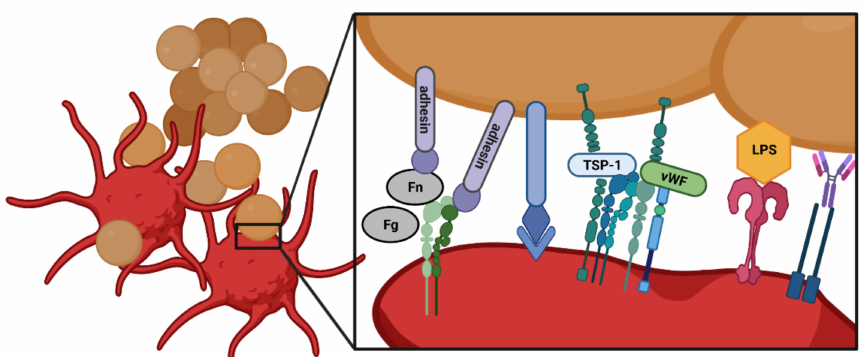
Figure 3. Binding of bacteria to platelets occurs either directly or indirectly. Bacterial adhesins with specific repeating units can utilize ECM proteins such as fibronectin (Fn), fibrinogen (Fg), TSP-1, or vWF as molecular bridges to bind to, e.g., integrin α II β 3 or other complexes of glycoproteins. Furthermore, some bacterial factors can directly bind to integrins, TLRs, or other platelet surface proteins. Bacteria already covered by IgGs are recognized by Fc γ RIIa. Created with BioRender.com (accessed on 21 March